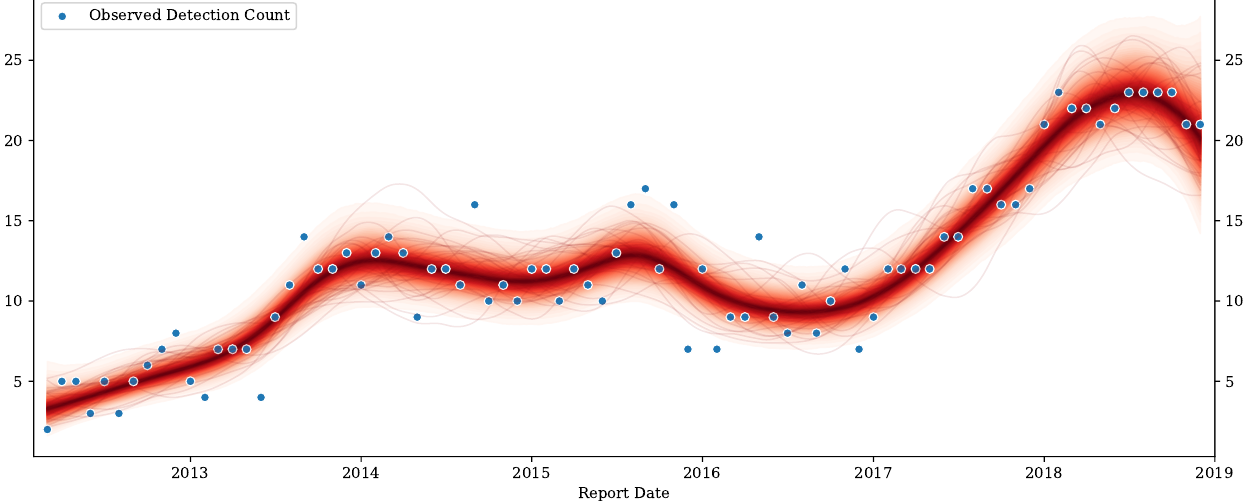
Figure 6. Posterior predictive samples showing the VIIRS detection count variations at the Blue Buttes Field. Blue points stand for the observed data while red lines represent the posterior